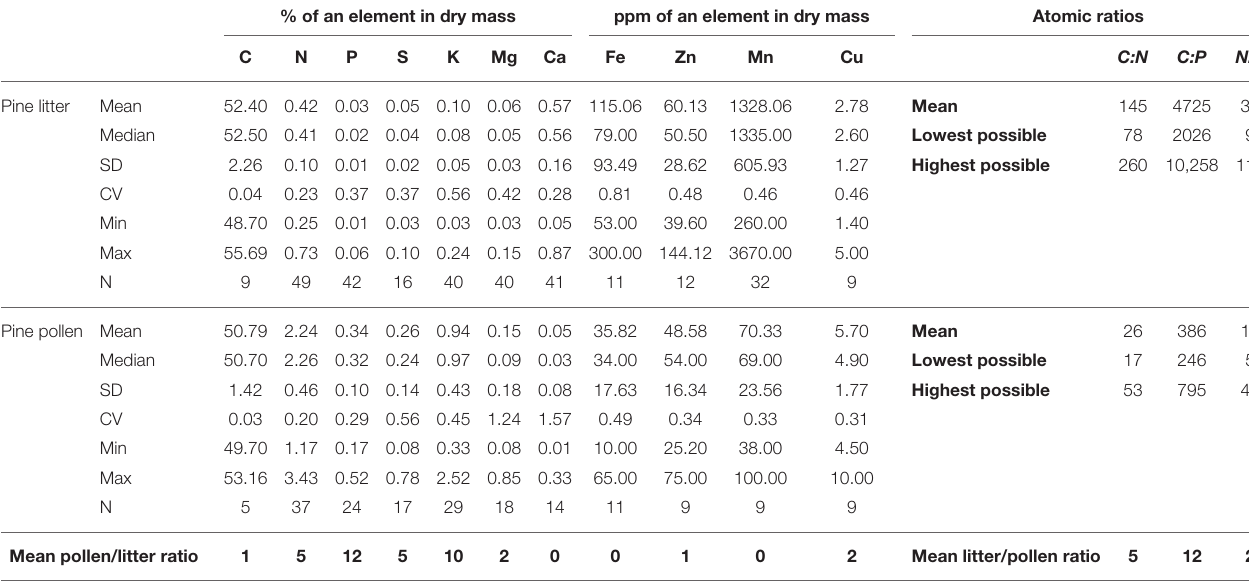
TABLE 1 | Dry mass element concentrations and stoichiometry of pine pollen compared with pine litter. % of an element in dry mass ppm of an element in dry mass Atomic